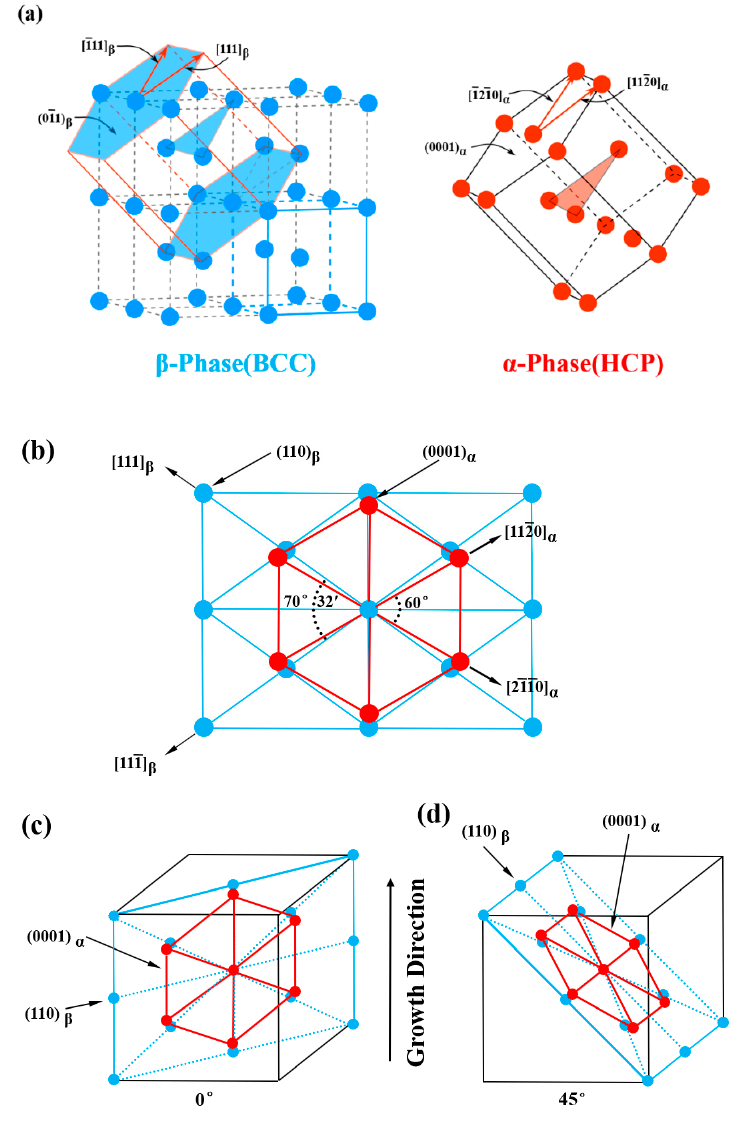
Figure 4. Schematic of atomic shifts for the b.c.c. β to h.c.p. α phase transition during DPT. ( a ) the h.c.p. lattice derives from the b.c.c. lattice, ( b ) atomic shifts model for β → α transformation, ( c , d )